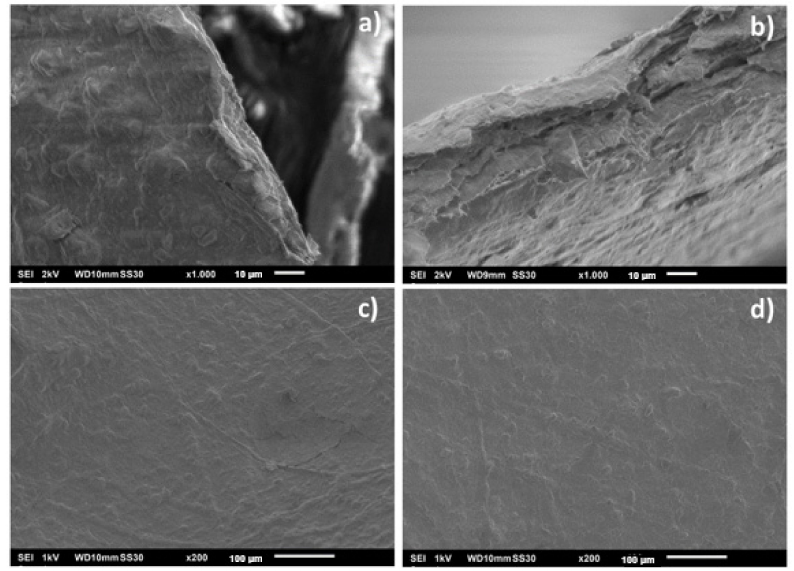
Figure 5. Scanning electron microscopy images of TEMPO CNF films containing 50% sepiolite.